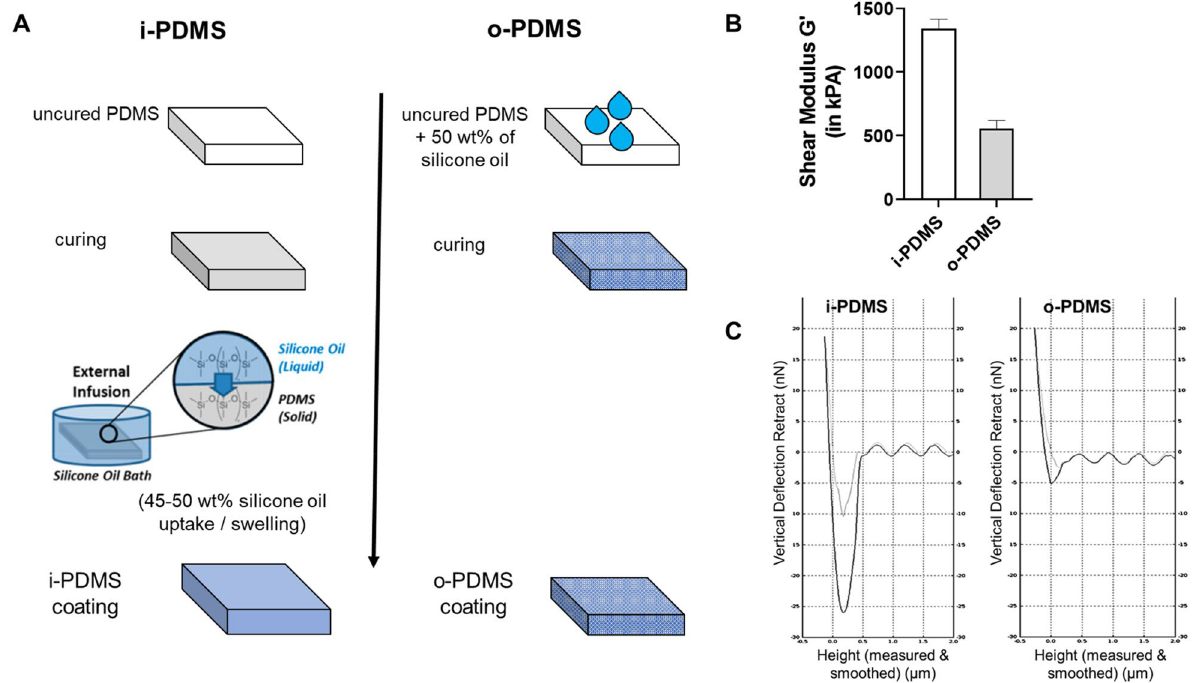
Figure 1. Description of the i-PDMS and o-PDMS systems. ( A ) Schematic of the fabrication processes for i-PDMS (post-cure oil infusion) and o-PDMS (pre-cure oil addition) coatings. ( B ) Shear modulus of i-PDMS (white bar) and o-PDMS (gray bar). ( C ) Lubricant overlayer detection using atomic force microscopy (AFM). The light grey curve represents the “extend” curve (the AFM tip approaching and then contacting the sample). The grey blue is the inverse “retract” curve, showing the adhesive force experienced by the AFM tip. This adhesive force is much higher for i-PDMS (~ 26 nN) compared to o-PDMS (~ 5 nN) due to the presence of the lubricant layer on i-PDMS.